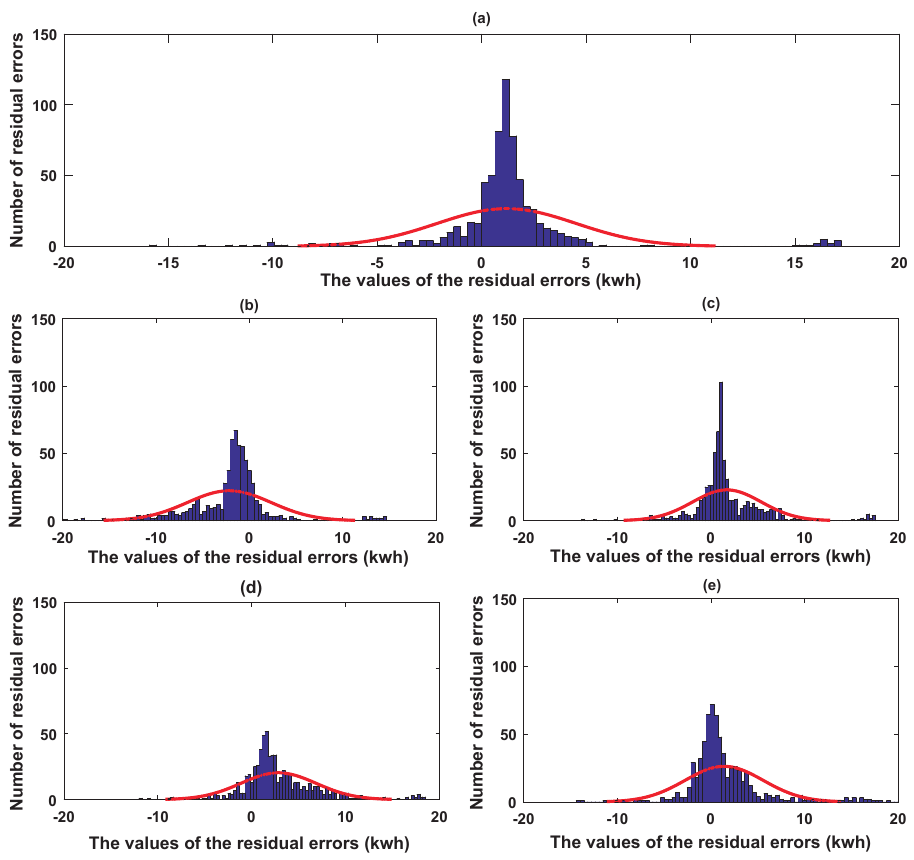
The values of the residual errors (kwh) Figure 13. Prediction error histograms of the five predictors constructed by utilizing the energy-consuming pattern: ( a ) hybrid DBN model; ( b ) BPNN; ( c ) GRBFNN; ( d ) ELM; and ( e ) SVR.